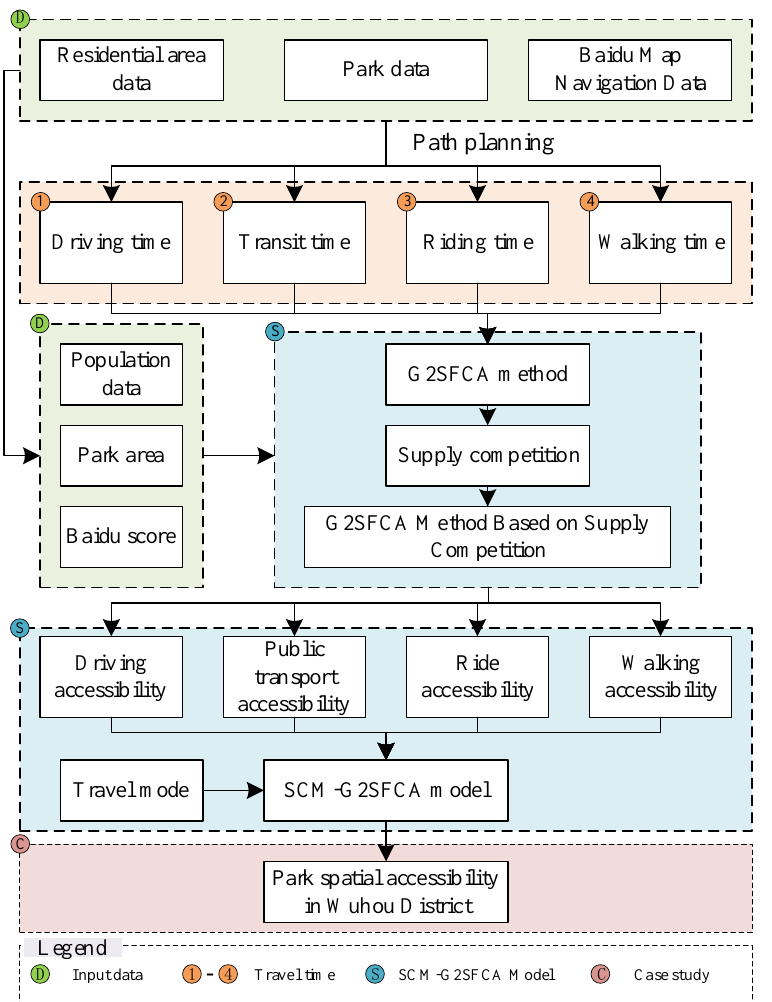
Figure 3. The technical framework of the spatial accessibility research on urban parks based on the SCM-G2SFCA